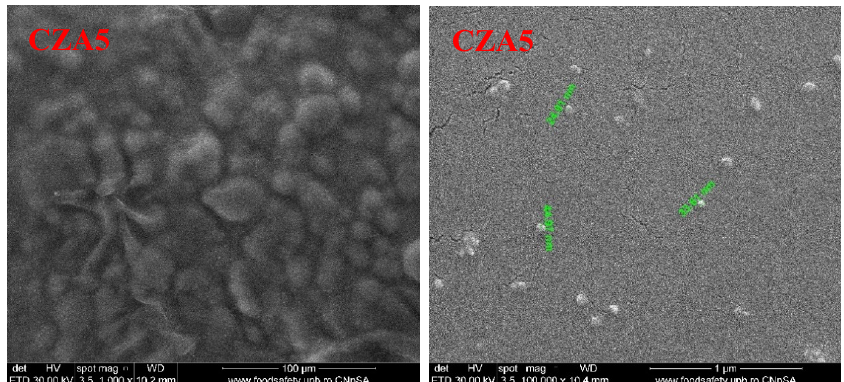
Figure 13. The SEM images for chitosan, CZA1, CZA2, CZA3, CZA4, and CZA5 films.